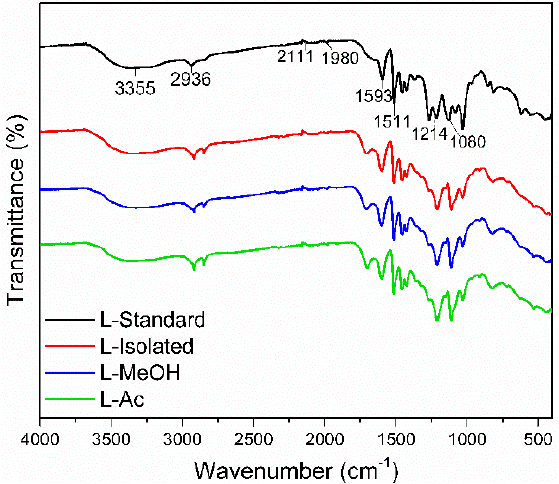
Figure 3. Typical FTIR spectra of lignin before and after fractionation.